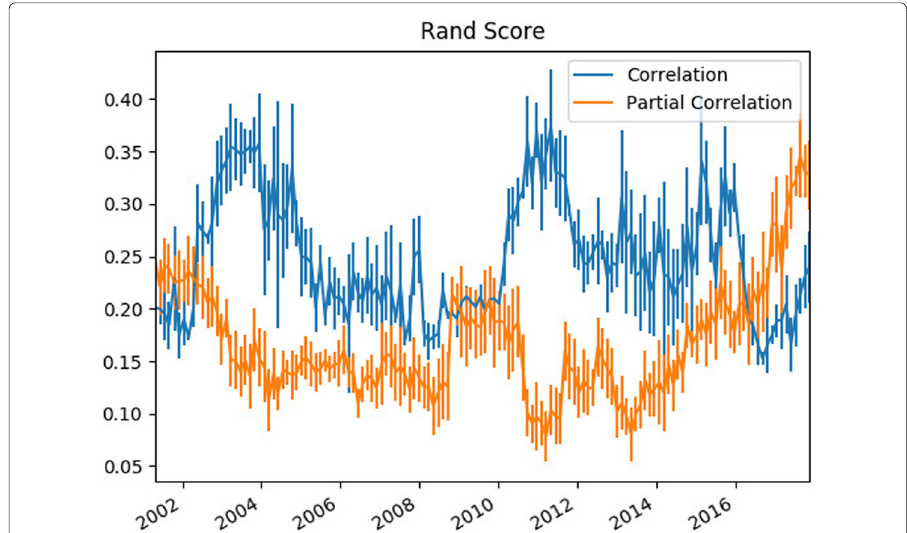
Fig. 11 Adjusted Rand Index score over time using Louvain community detection algorithm. In general the partial correlation networks have less success in uncovering the sector structure than the correlation networks although there are time periods where this is not the case. This could be due to the reduction in supposedly indirect correlations by the partial correlation